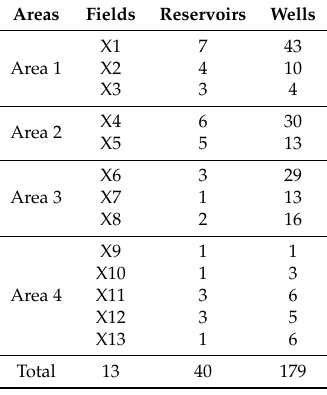
Table 1. Detailed breakdown of the distribution of the areas, fields, reservoirs and wells of the Block K—Angola (Courtesy: Sonangol